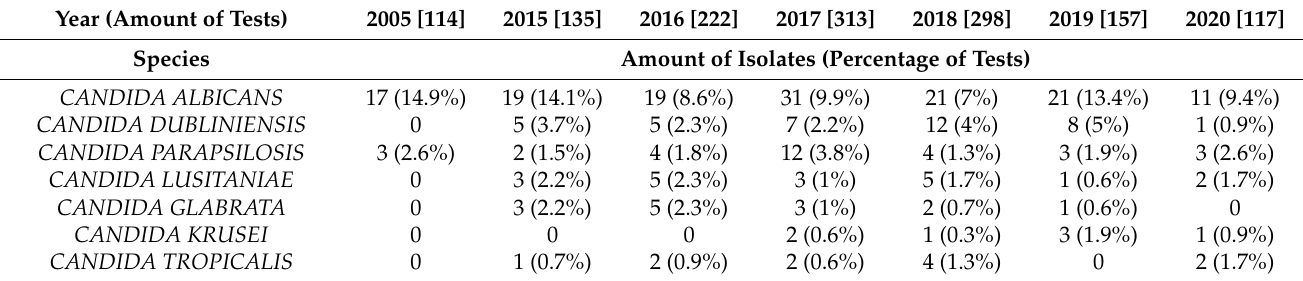
Table 5. Yeast species isolated from the lower respiratory tract samples in PCICU patients.